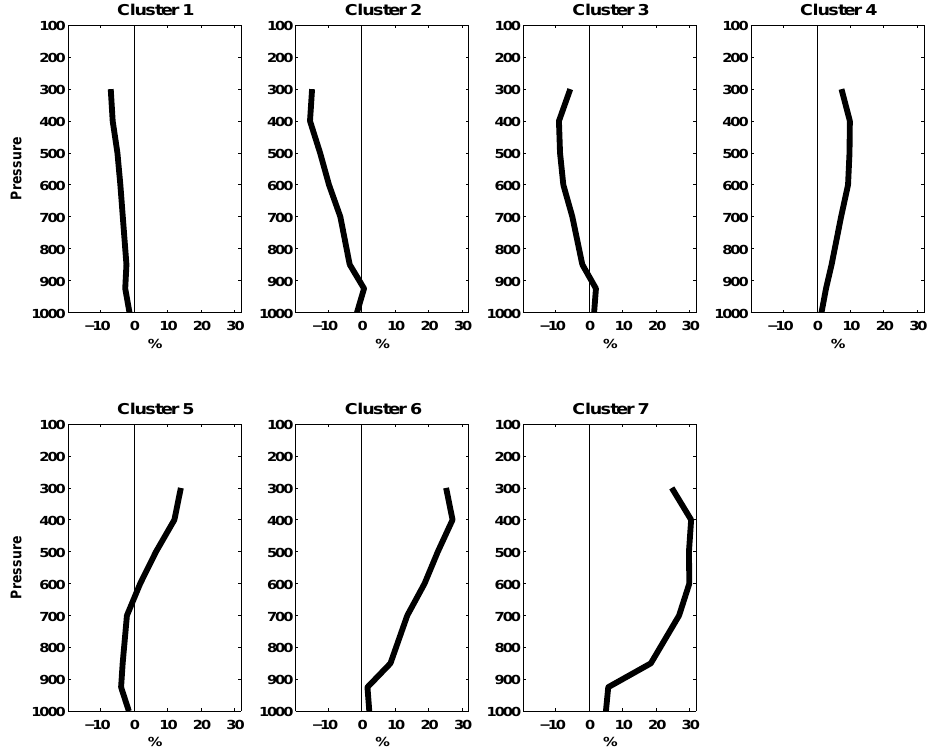
Fig. 2. Vertical profiles of mean perturbation relative humidity for each cluster from the NCEP